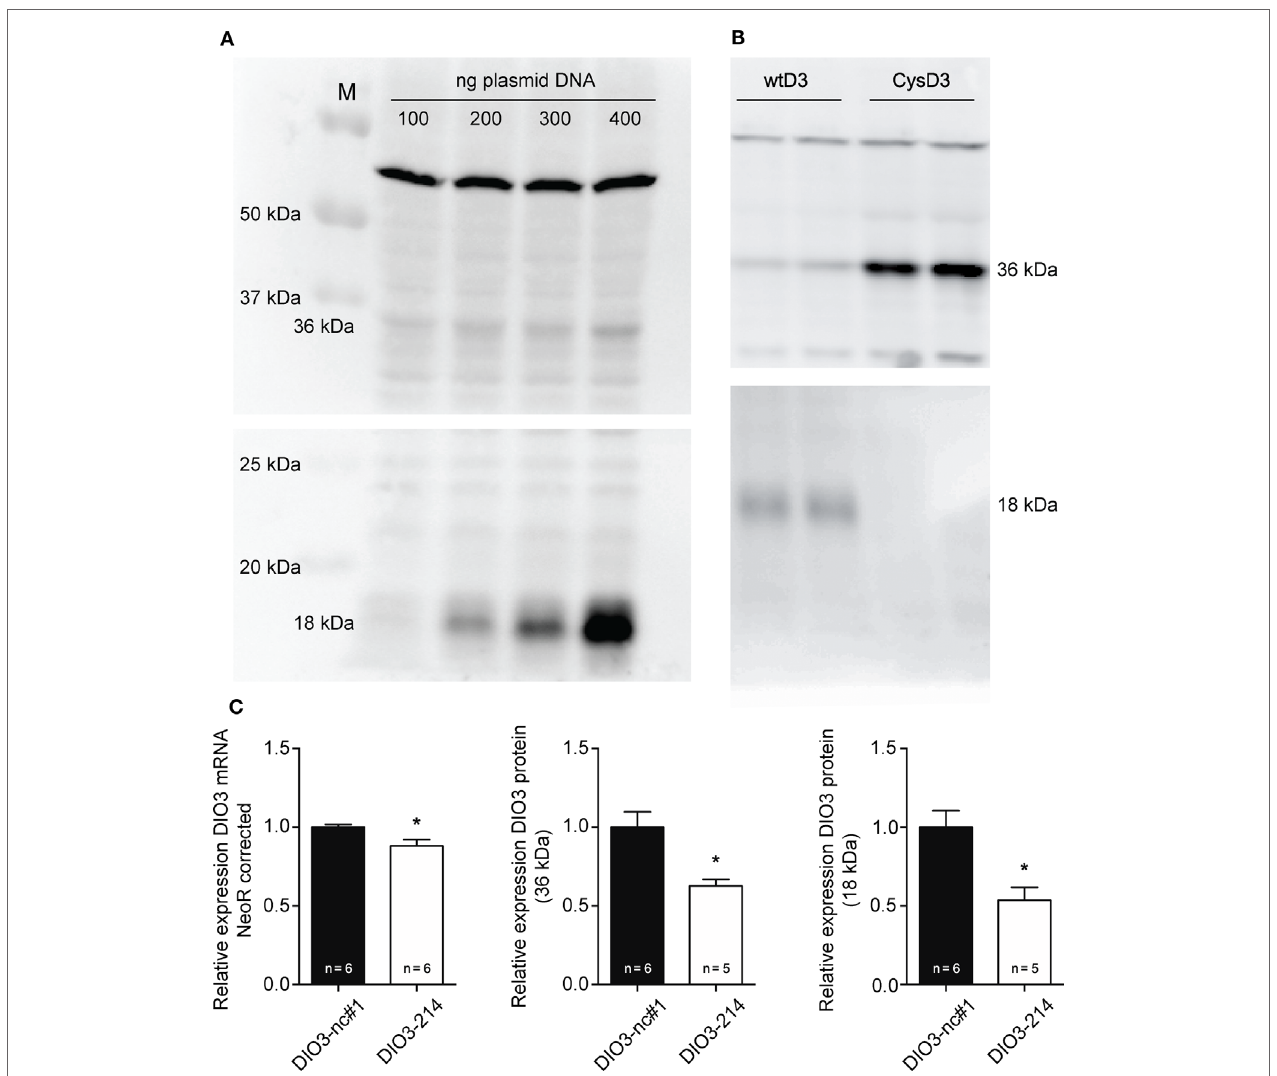
FigUre 4 | Western blot analysis of DiO3 expression in vitro . (a) Transfection of COS-7 cells with increasing amounts of wtD3 plasmid confirmed the specificity of Ab 677 for full-length DIO3 (36 kDa) and of Ab 675 for truncated DIO3 protein (18 kDa). Equal amounts of protein were loaded. (B) COS-7 cells transfected with the CysD3 plasmid confirmed the expression of the truncated isoform of DIO3 in COS-7 cells transfected with the wtD3 plasmid, which was detected with Ab 675 (18 kDa) (lower blot; the upper blot is stained using Ab 677). (c) COS-7 cells were transfected with 100 ng of the wtD3 plasmid containing full-length human DIO3 together with either mimic-214 (DIO3 – 214) or Negative control miR-1 (DIO3-nc#1) at a final concentration of 500 nM. Addition of the negative control miR-1 did not significantly affect transfection efficiency (results not shown). Analysis of COS-7 cells transfected with empty pCDNA vector using Ab 677 and Ab 675 did not show bands at 36 kDa and 18 kDa, respectively, confirming antibody specificity (Figure S2 in Supplementary Material). Expression levels of the neomycin-resistance gene were analyzed using qPCR and used to normalize transfection efficiency. Values are means ± SEM, normalized to the value of the parameter in the DIO3-nc#1 group, * p <